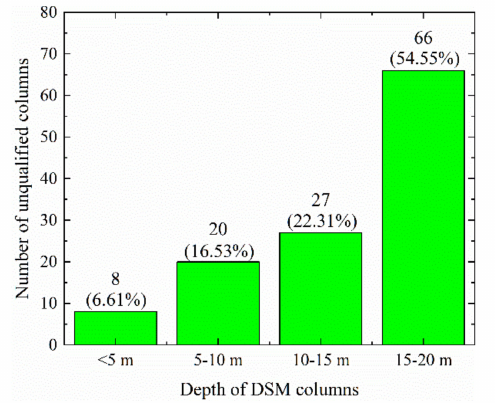
Figure 8. The unqualified DSM columns at different